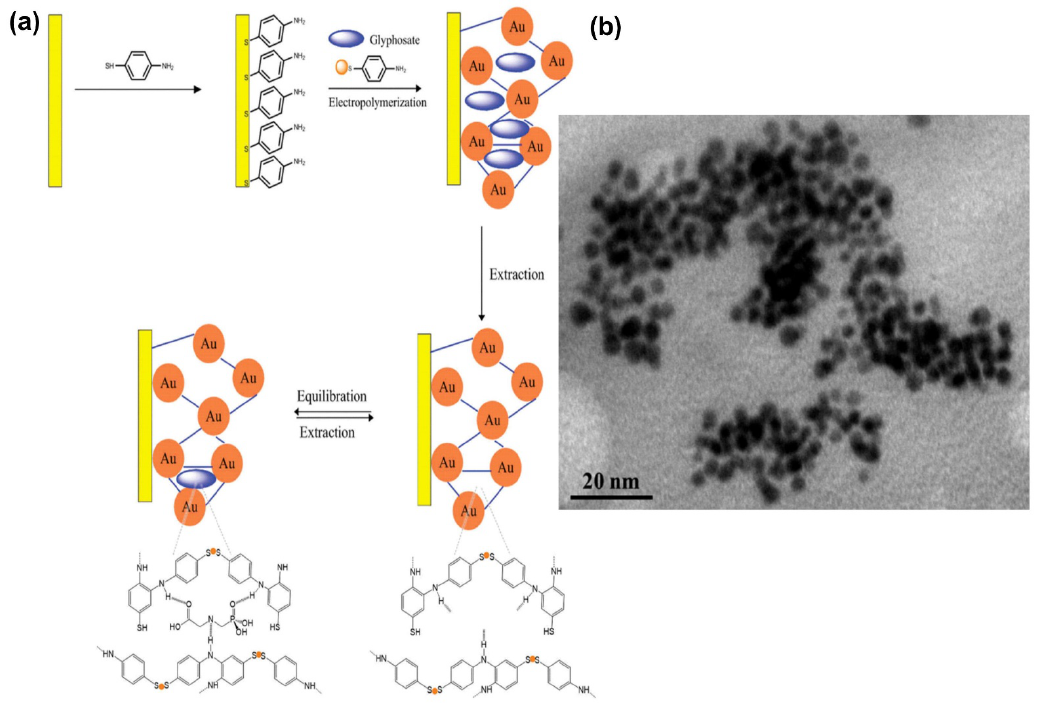
Figure 4. Fabrication steps of an imprinted sensor for GLYP detection: ( a ) electropolymerization in the template presence, template extraction, and equilibration with the unknown GLYP solution for its detection. Au bullets present AuNPs, before and after electropolymerization of polythioaniline, entrapping GLYP molecules as templates. At the bottom of the figure, the hydrogen bonds between aniline moieties and the O and N atoms of GLYP molecules in the MIP-MOF film are presented, and empty cavities after the extraction of GLYP molecules. ( b ) TEM observation of p-amino thiophenol- functionalized gold nanoparticles. Reprinted with permission from [100]. Copyright 2015 Taylor & Francis.